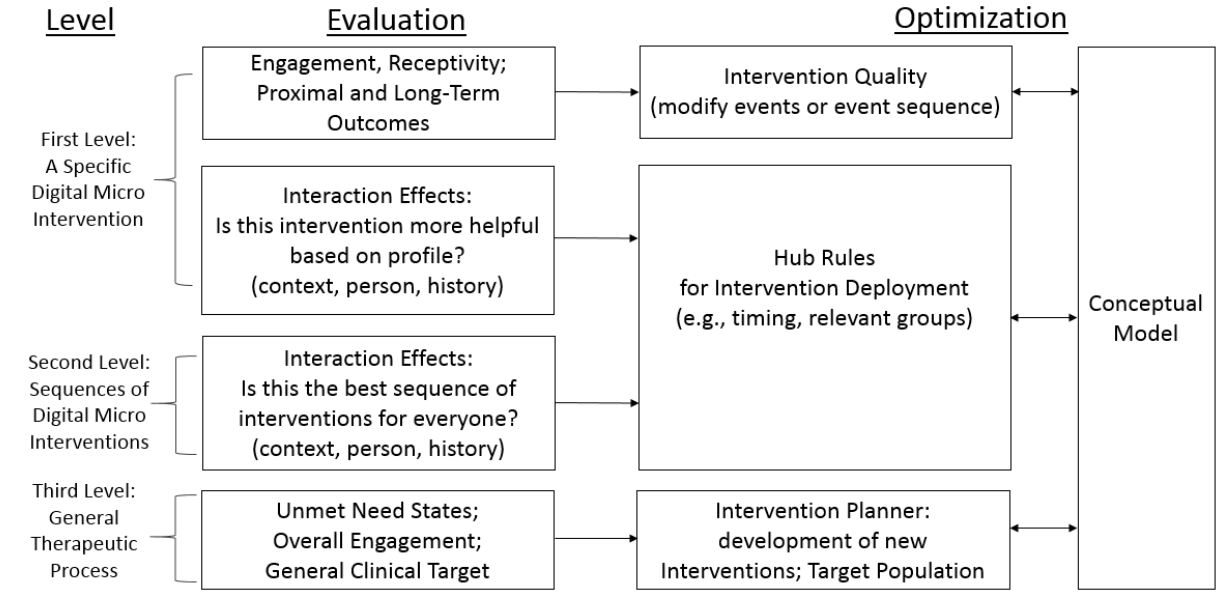
Figure 4. Levels of